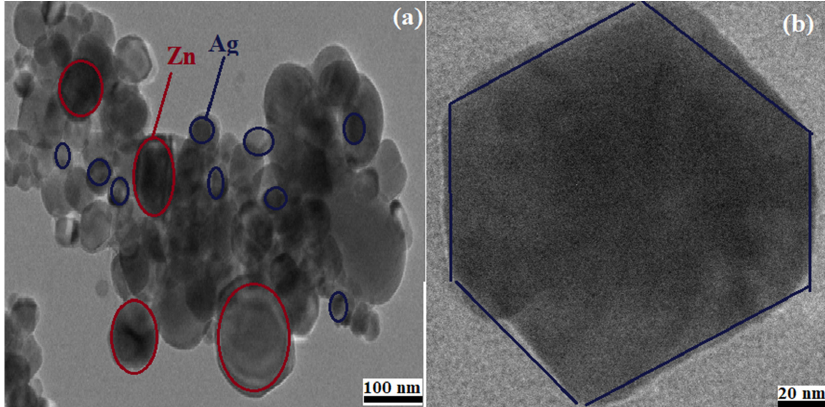
Figure 5. ( a ) TEM image of ZnV@Ag NC. ( b ) High ‐ resolution TEM image of ZnV@Ag NC.